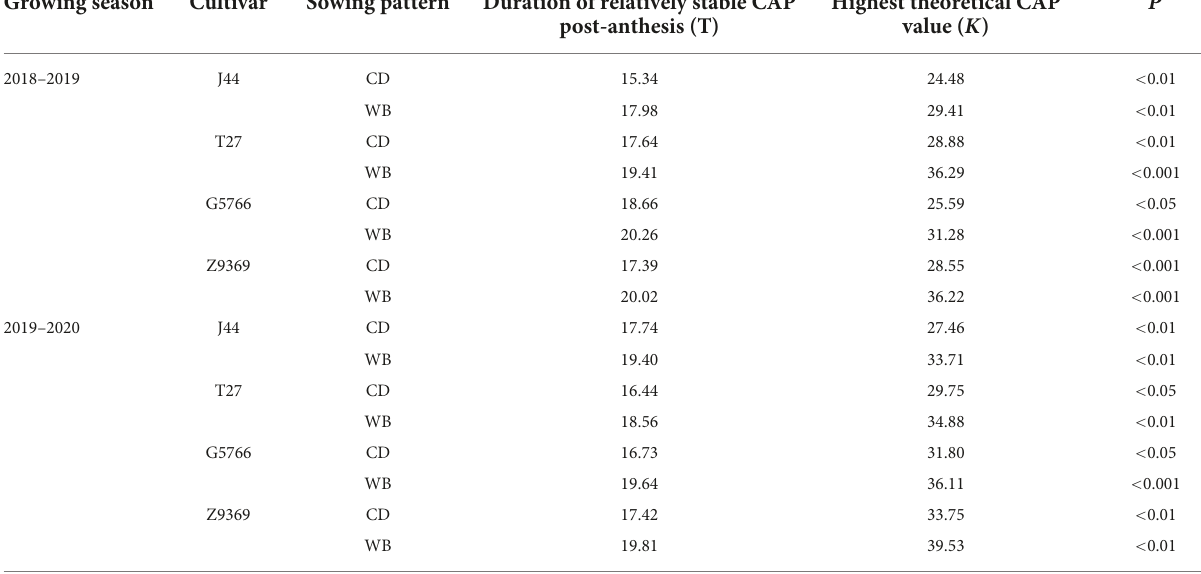
TABLE 4 Effect of sowing pattern on the fitting of canopy apparent photosynthesis (CAP) model parameters of bread wheat post-anthesis. Growing season Cultivar Sowing pattern Duration of relatively stable CAP post-anthesis